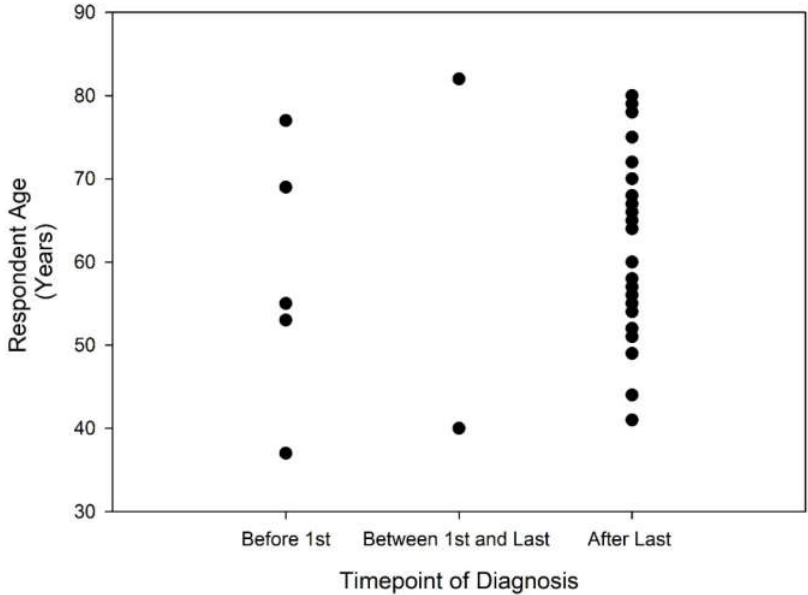
Figure 1. Respondent age as a function of the timepoint of HHT diagnosis.